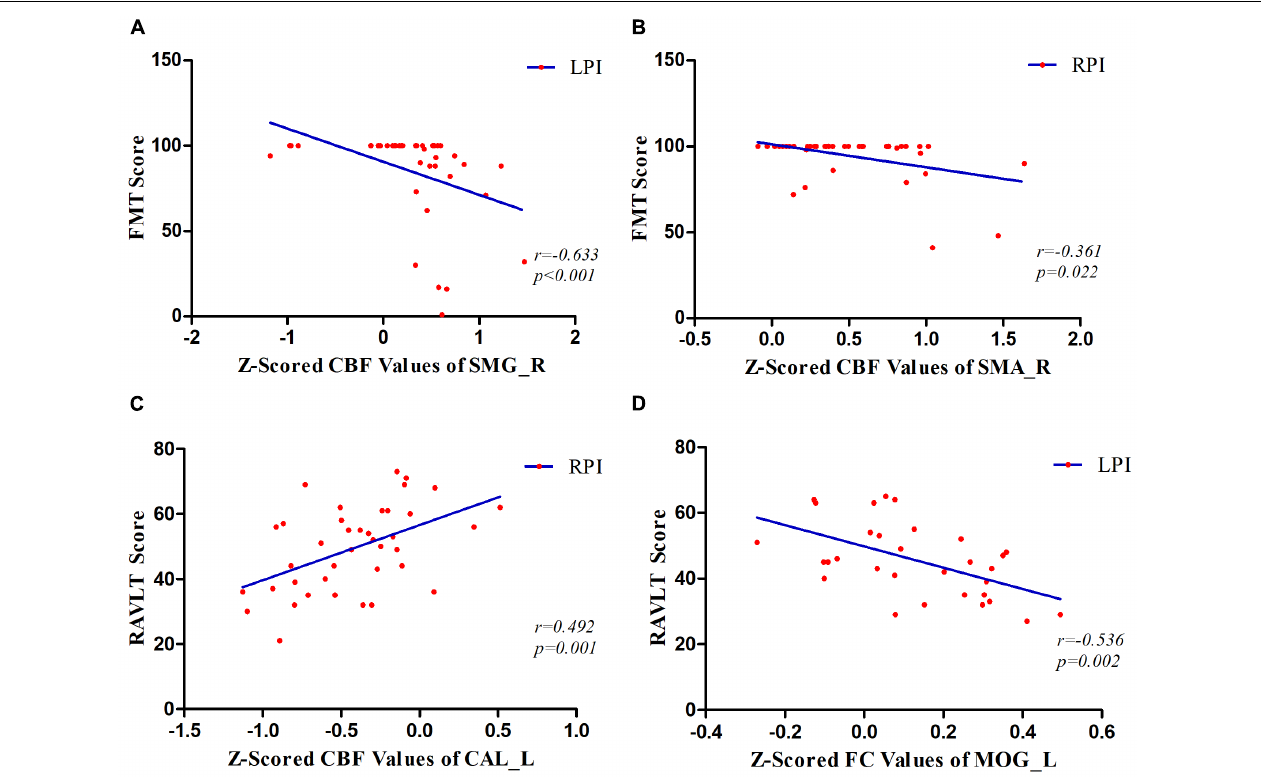
FIGURE 6 | Correlations between z -scored CBF values, FC values, and behavioral scores over time. (A) The patients in the LPI group showed a significantly negative correlation between dynamic changes of z -scored CBF values in the SMG_R and FMT scores over time. (B) In the RPI group, the results showed a negative correlation between the longitudinal z -scored CBF values of SMA_R and FMT scores. (C) In the RPI group, the results showed a positive correlation between longitudinal changes of z -scored CBF values in the CAL_L and RAVLT scores. (D) In the LPI group, the longitudinal z -scored FC values between SMG_R as seed and MOG_L were negatively associated with RAVLT scores. SMG_R, right supramarginal gyrus; SMA_R, right supplementary motor area; CAL_L, left calcarine sulcus; MOG_L, left middle occipital gyrus; FMT, Fugl–Meyer Test; RAVLT, Ray Auditory Verbal Learning Test; LPI and RPI, left and right pontine infarction